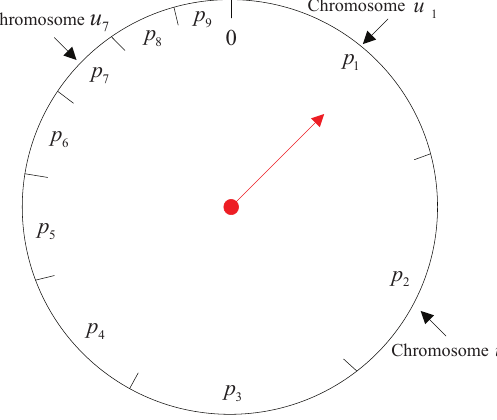
Figure 5. The diagram of the roulette